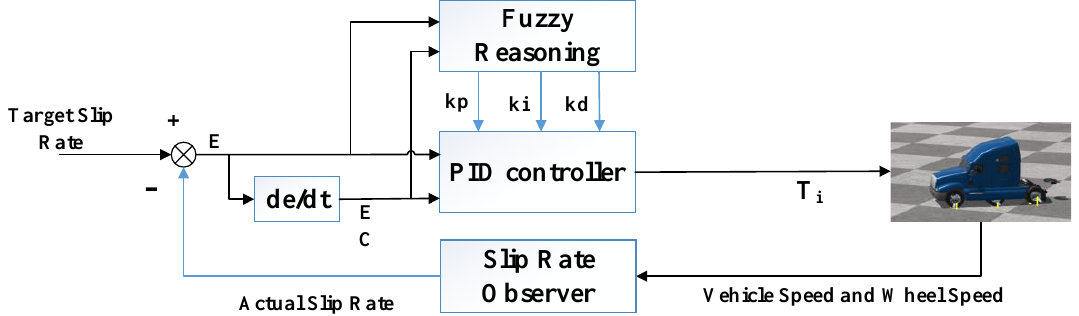
Figure 4. Slip rate controller based on adaptive fuzzy PID.